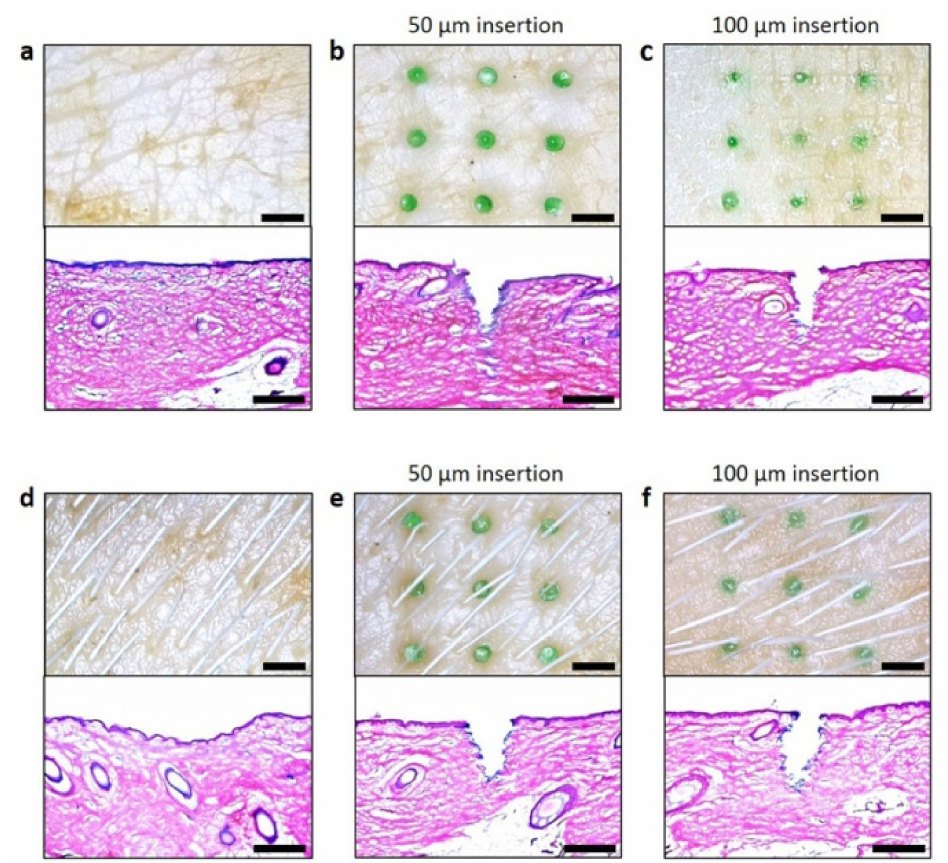
Figure 17. Microscopy images and histological examinations of hairy and hairless pig